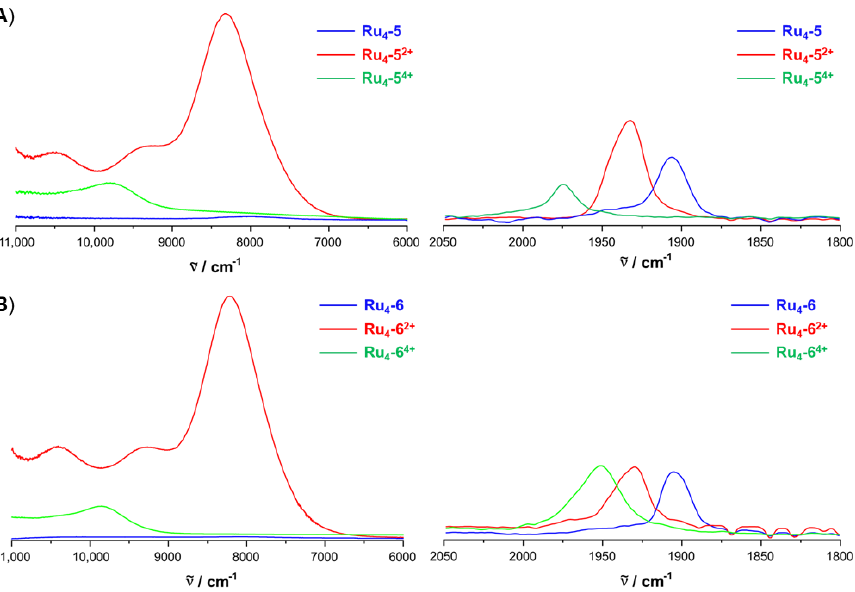
Figure 5. Spectroscopic changes in the mid-IR [Ru(CO)] and NIR spectra of ( A ) Ru 4 -5 (blue) upon oxidation to [ Ru 4 -5 ] 2+ (red) and [ Ru 4 -5 ] 4+ (green) and ( B ) of Ru 4 -6 (blue) upon oxidation to [ Ru 4 -6 ] 2+ (red) and [ Ru 4 -6 ] 4+ (green) in CH 2 Cl 2 at 298 K ( c = 80 mM). The dications [ Ru 4 -5 ] 2+ or [ Ru 4 -6 ] 2+ and tetracations [ Ru 4 -5 ] 4+ or [ Ru 4 -6 ] 4+ were obtained by treatment of the neutral macrocycle with 2 equivalents of ferrocenium hexafluorophosphate (Fc + PF 6 − ) or 4 equivalents of acetylferrocenium hexafluoroantimonate (AcFc + SbF 6 − ), respectively.